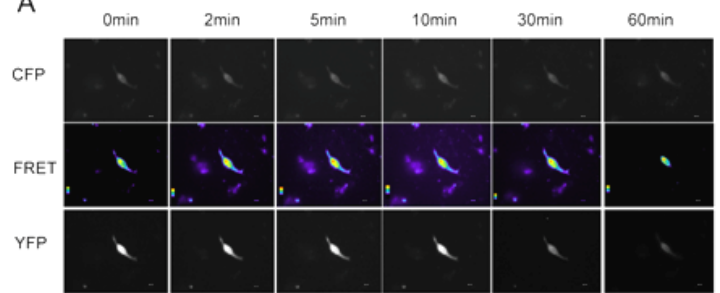
Figure 1. Leptin activated RhoA in human NP cells. ( A ) Human NP cells expressing pRaichu-1237 were imaged as in this figure. The corrected FRET images were pseudo-colored to visualize the localization of active RhoA and FRET intensity. In the color scale, red represents a high FRET signal and blue represents a low signal; ( B ) The YFP/CFP emission ratio was measured by taking the mean intensity of a ROI of the corrected FRET image, divided by the mean intensity of the same region on the CFP image. An average of one cell was quantified for each time point and each image is representative of multiple cells. For each experiment, human NP cells expressing pRaichu 1237× were imaged from 18 h post-transfection. * p < 0.05; ** p < 0.01, values obtained in the presence of leptin (10 ng/mL) versus control (0 min). Scale bars represent 10 μ m. Error bars represent